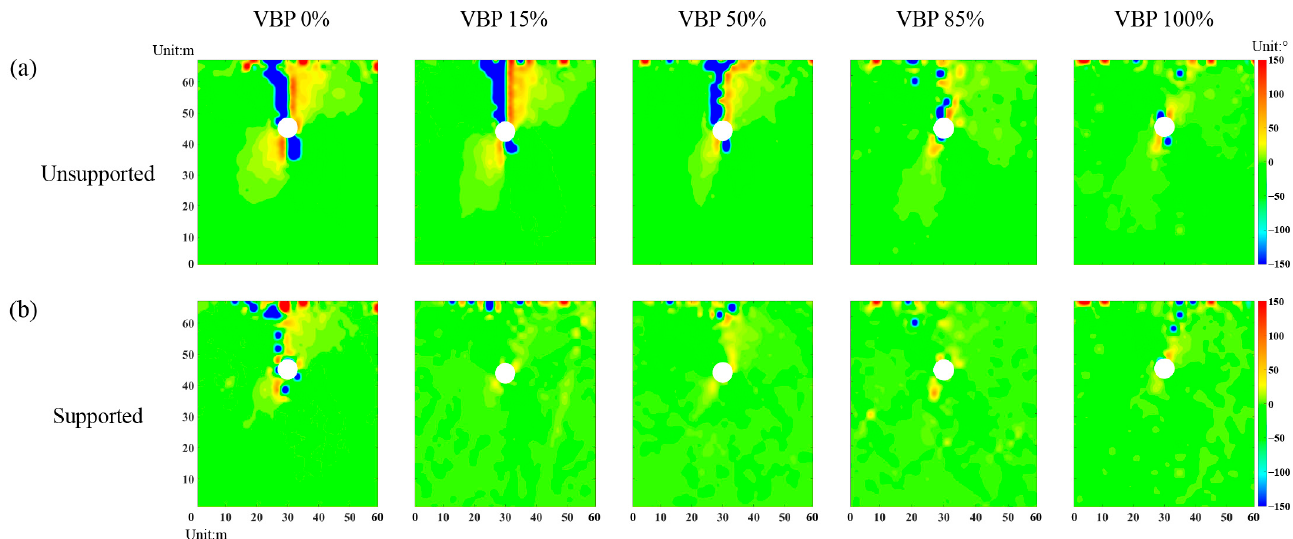
Figure 15. The distribution of the stress variation angle in the ground of ( a ) unsupported tunnel excavation and ( b ) supported tunnel excavation.